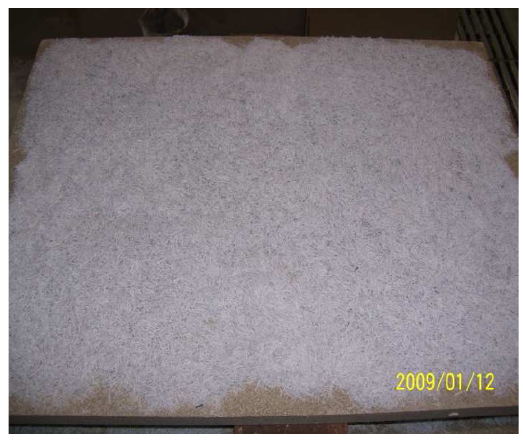
Figure 1. Rice husk ash after burning